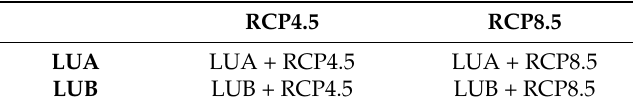
Table 2. Climate and Land use/cover changes